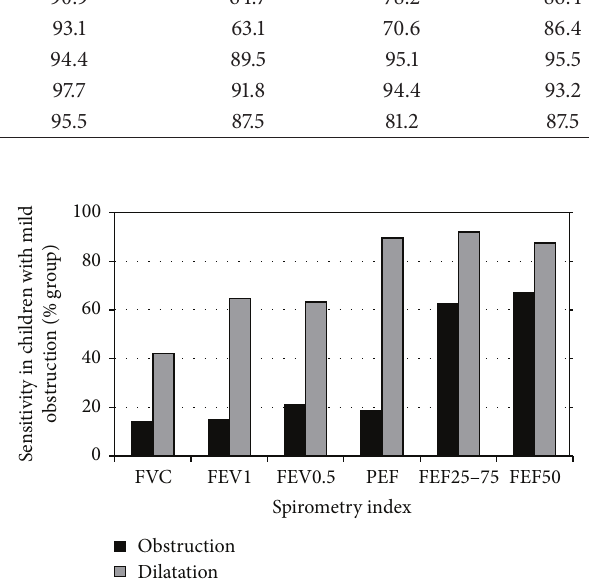
Figure 1: Detection of obstruction and response to BDR by the various spirometry indices, in children with mild